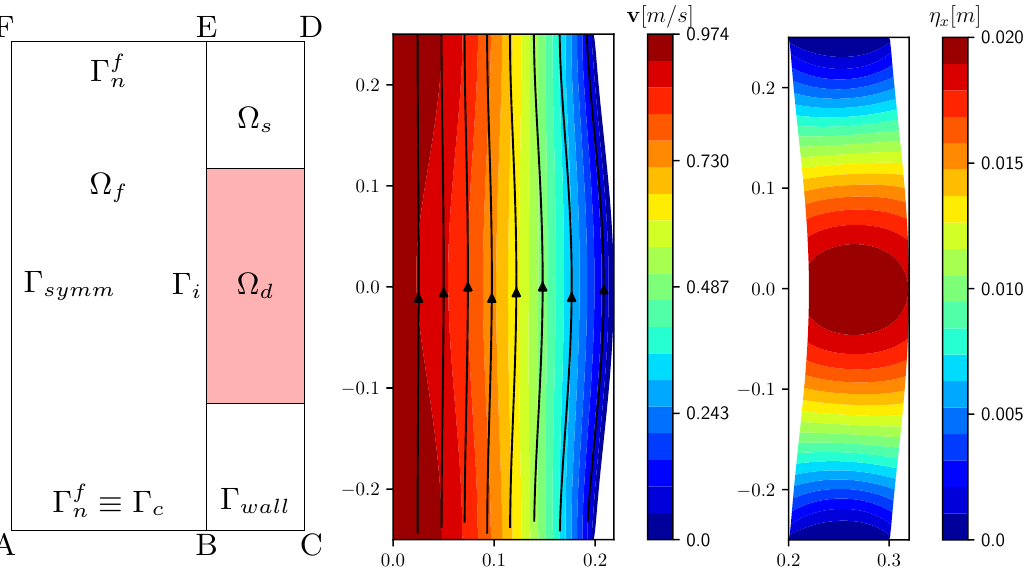
Figure 1. Geometry and controlled region defined by dotted square on the right Ω d ( left ). Reference case with velocity profiles and streamlines in the liquid ( center ). Solid displacement field η x for the same reference configuration ( right